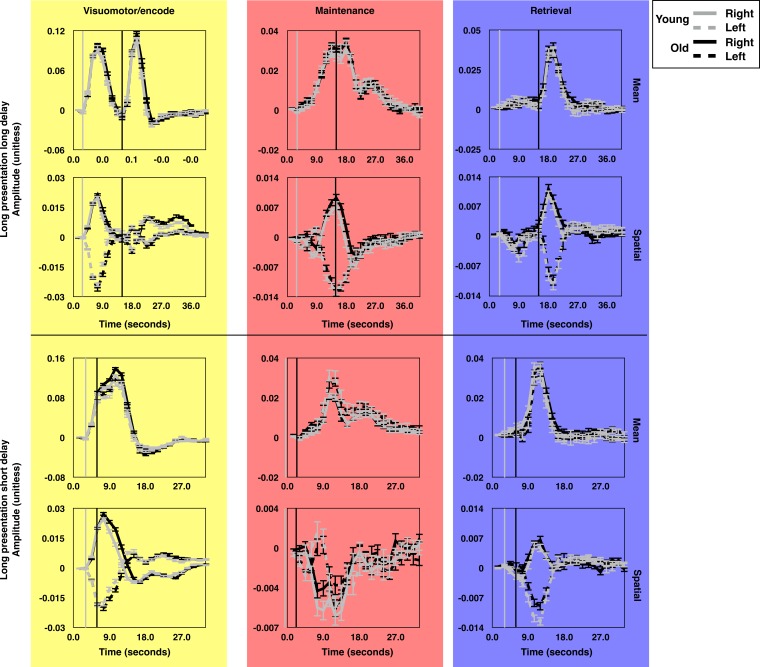
The average time course of brain state expression by age group.The average time courses of expression for each brain state component during long presentation, long delay trials (top subset) and short presentation short delay trials (bottom subset). Each panel depicts the average time courses for the oldest (19.9 < Age ≤ 32.6; gray lines) and youngest (8.83 ≤ Age ≤ 19.9; black lines) halves of the subject pool. The time courses for trials during which targets were presented in the left (dashed) and right (solid) visual hemifields are rendered separately. The gray and black vertical lines indicate the time of visually-guided and memory-guided saccade signals respectively. As in Figure 2, yellow, red, and blue background colors correspond to VME-, maintenance- and retrieval-related brain state components. Error bars depict one standard error of the mean. These figures depict the absence of significant age related differences in the mean amplitude of expression of the canonical task-related brain states.